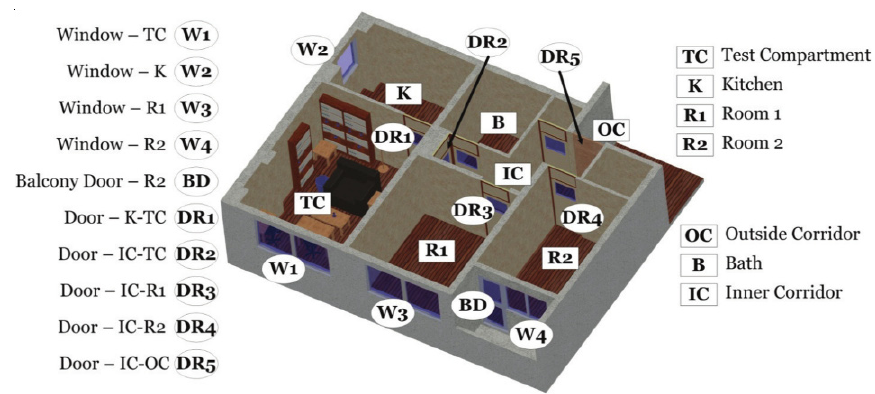
Figure 1. Compartment geometry.